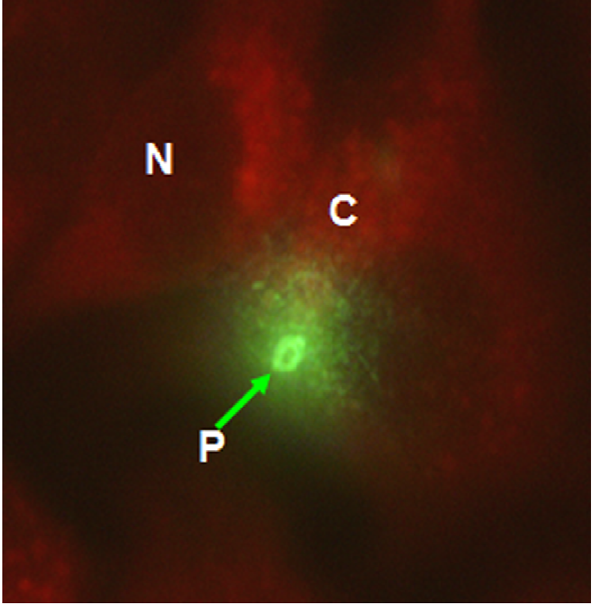
Figure 3. Multiple Pv liver stage parasites were seen in single hepatocyte in a 3 Day culture. HepG2-A16 cells were infected with Pv spz and the liver stage trophozoites were stained with the anti- PvCSP mAb, NVS3. Some HepG2-A16 cells were seen with multiple liver stage parasites (400X magnification). N : Nucleus of hepatocyte, C: Cytoplasm of hepatocyte, White Arrows: Individual 3 Day hepatocyte stage Pv.